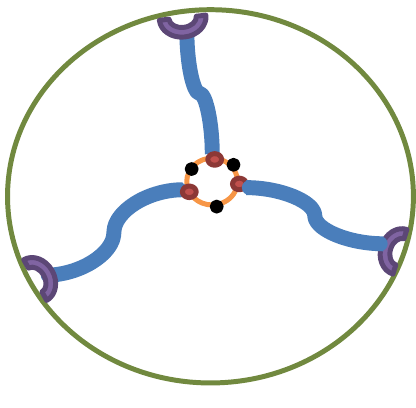
Figure 2 . Open-closed amplitude on disk where purple lines are open string vertex